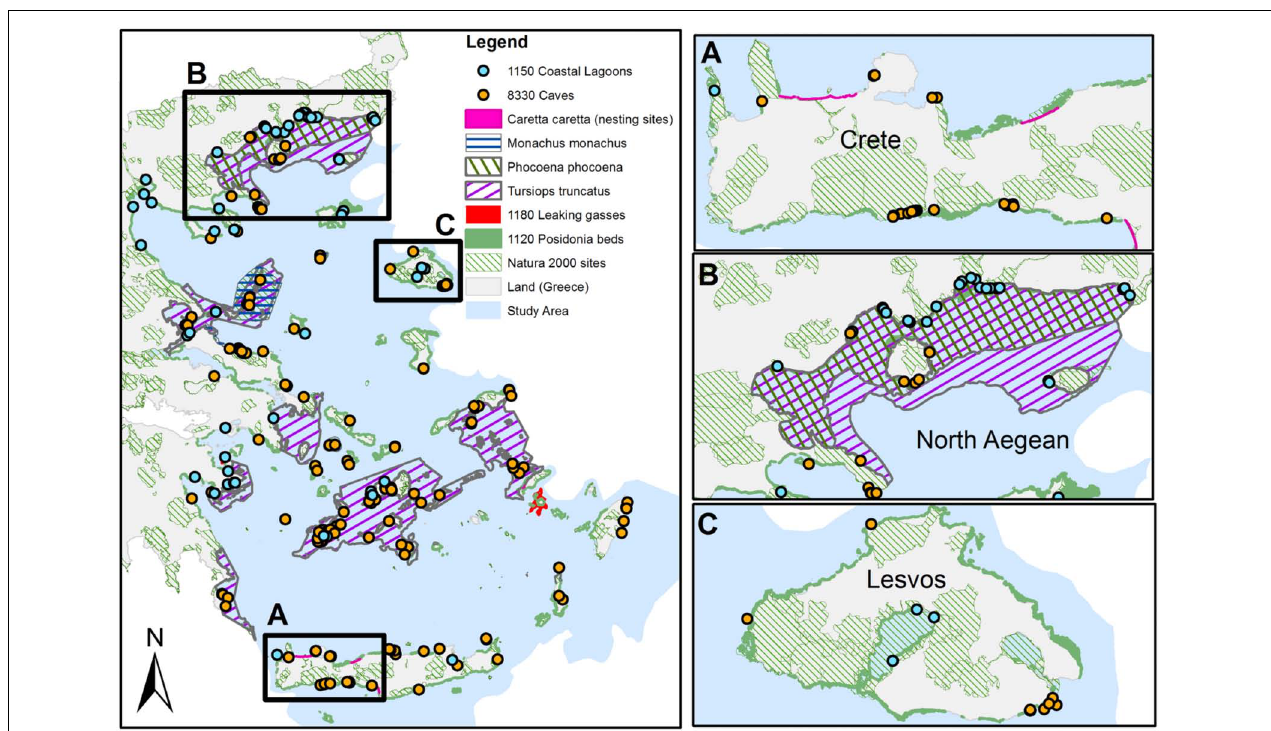
FIGURE 3 | The distribution of Natura 2000 sites in the Aegean Sea and their overlap with the distribution of habitats and species of EU importance (selected areas are highlighted in A–C ). Distributional data from Sini et al.